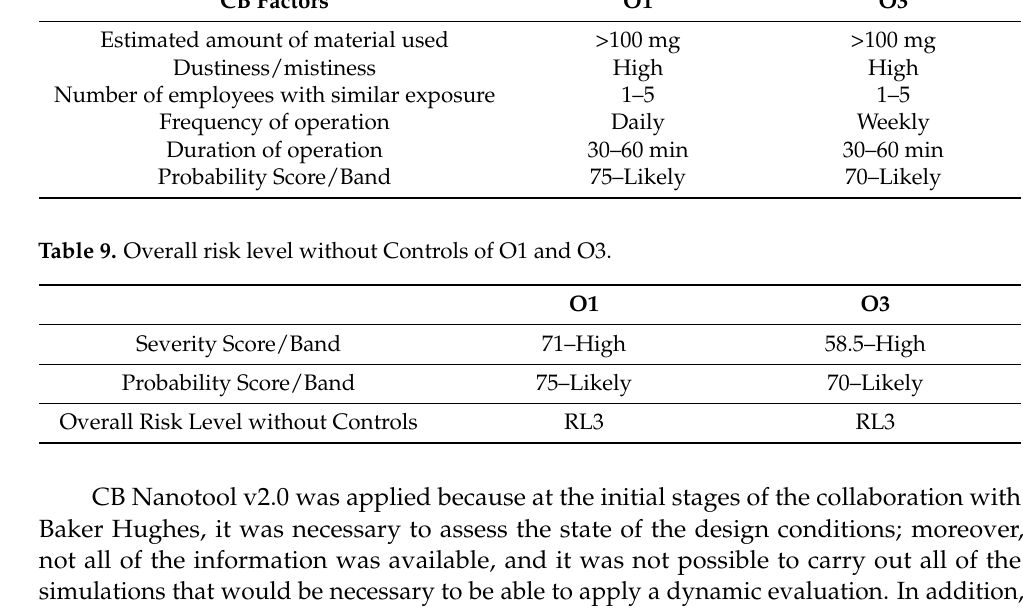
Table 8. Probability scores of O1 and O3.